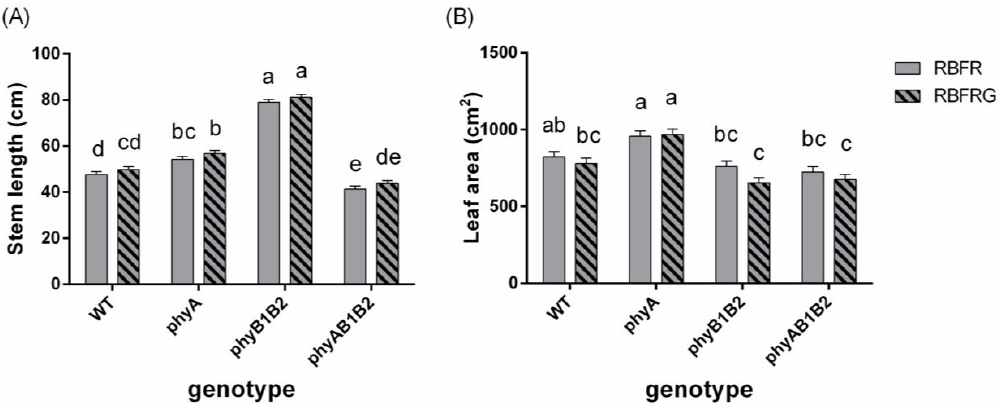
Figure 3. Effects of partial (20%) substitution of red/blue (RB; 3:1) with green (G) light while keeping the PSS constant on ( A ) the stem length and ( B ) plant leaf area of tomato plants 21 days after treatment. Four genotypes were studied: WT (Moneymaker, wild-type), phyA (phytochrome A-deficient), phyB1B2 (phytochrome B1- and B2-deficient), and phyAB1B2 (phytochrome A-, B1-, and B2-deficient). Light treatment and genotype did not significantly interact (for stem length, p = 0.999; for leaf area, p = 0.638). The effects of light treatment were not significant (for stem length, p = 0.075; for leaf area, p = 0.34), but the effects of genotype were significant ( p < 0.001 for